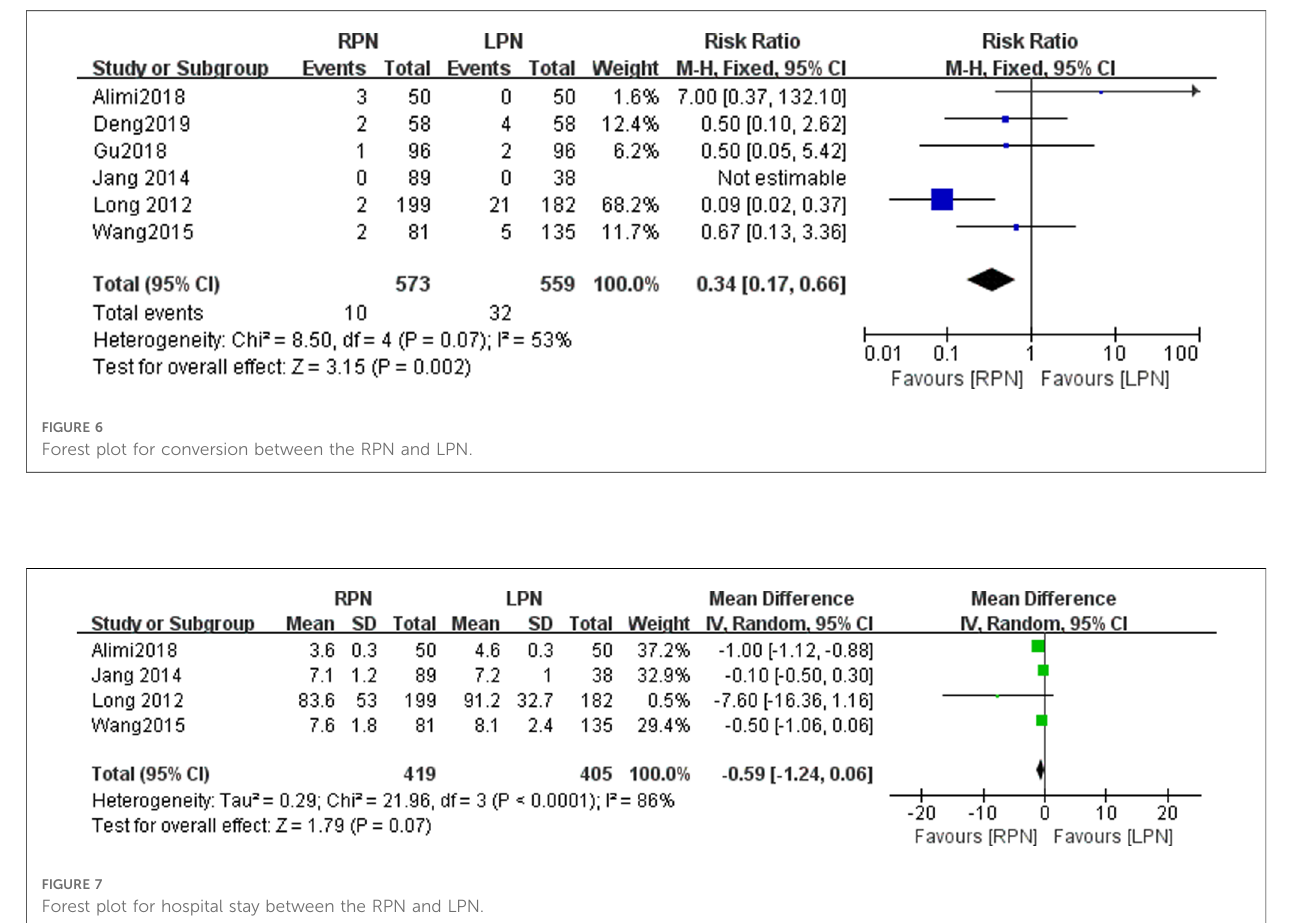
difference was found in the postoperative function between the RPN and LPN groups ( n = 524; 235 patients in the RPN group and 289 patients in the LPN group; WMD: 3.32; 95% CI: 0.73 – 5.91; p = 0.01; I 2 = 57; random-effects model; Figure 10 ).